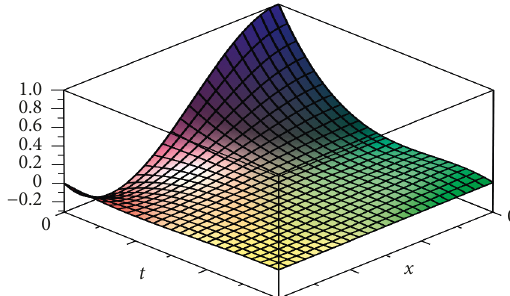
Figure 1: The approximate solution of ζ